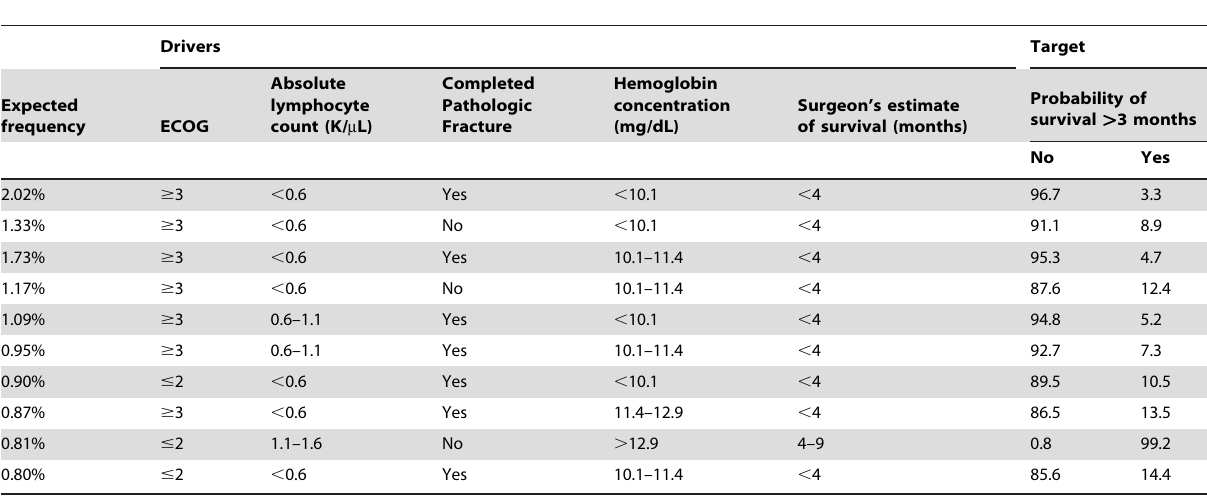
Table 2. Posterior estimates of survival at 3 months (10 most frequent